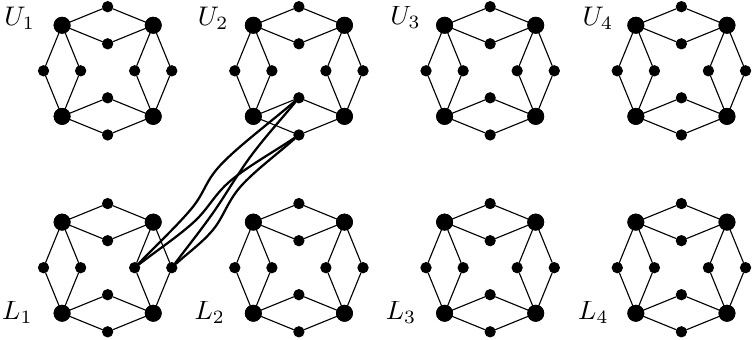
Figure 1. The graph W 4 (the edges of only one of the k 2 joining bicliques is